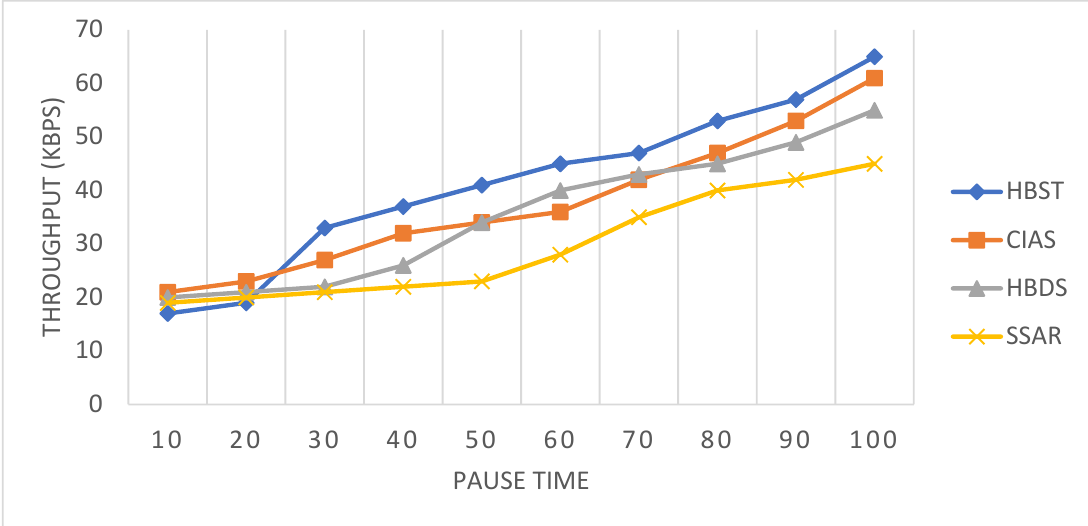
Figure 2. Network throughput with 25% selfish nodes.